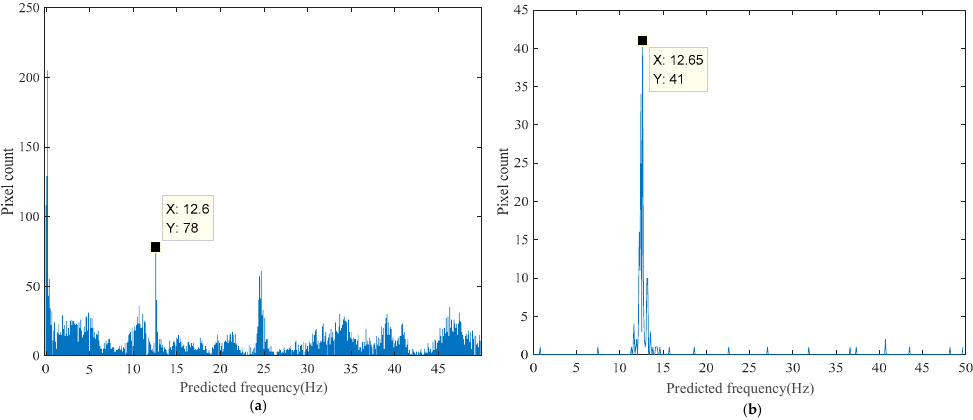
Figure 13. Field experimental results of the proposed method: ( a ) Histogram of predicted frequency distribution; ( b ) Histogram of predicted frequency distribution after edge enhancement.